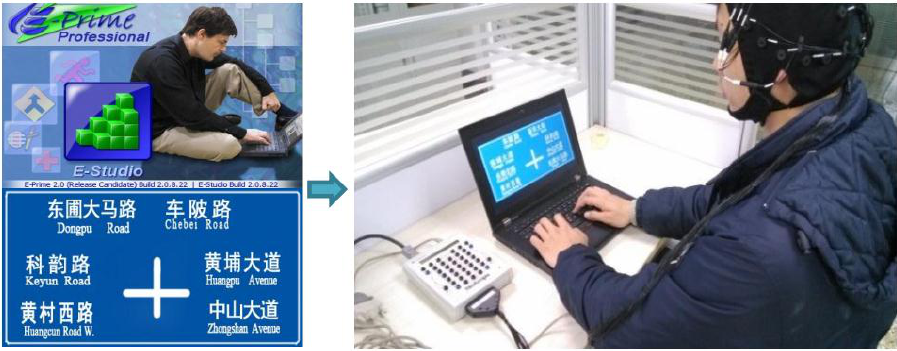
Figure 1. Apparatus and materials of Study 1.